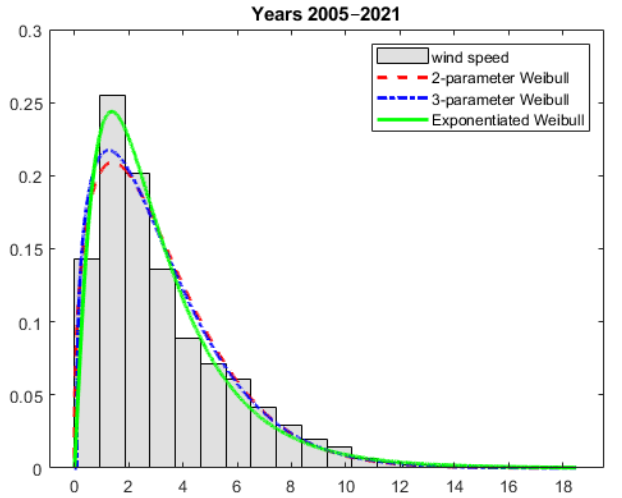
Figure 5. Modelled probability distributions fitted to the histogram of the wind speed data – the entire considered period.